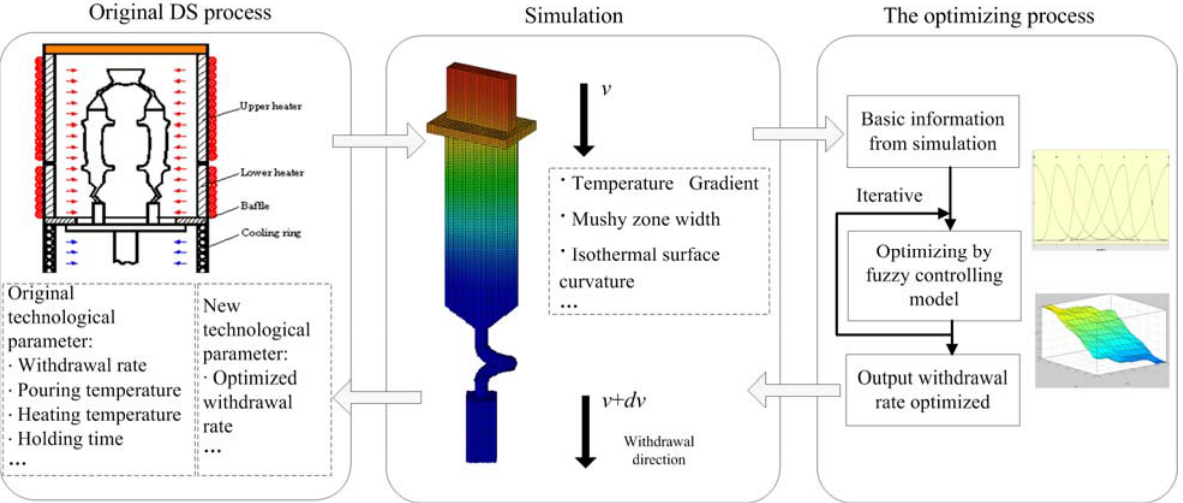
Figure2. The framework of DS processes, optimized by simulation.